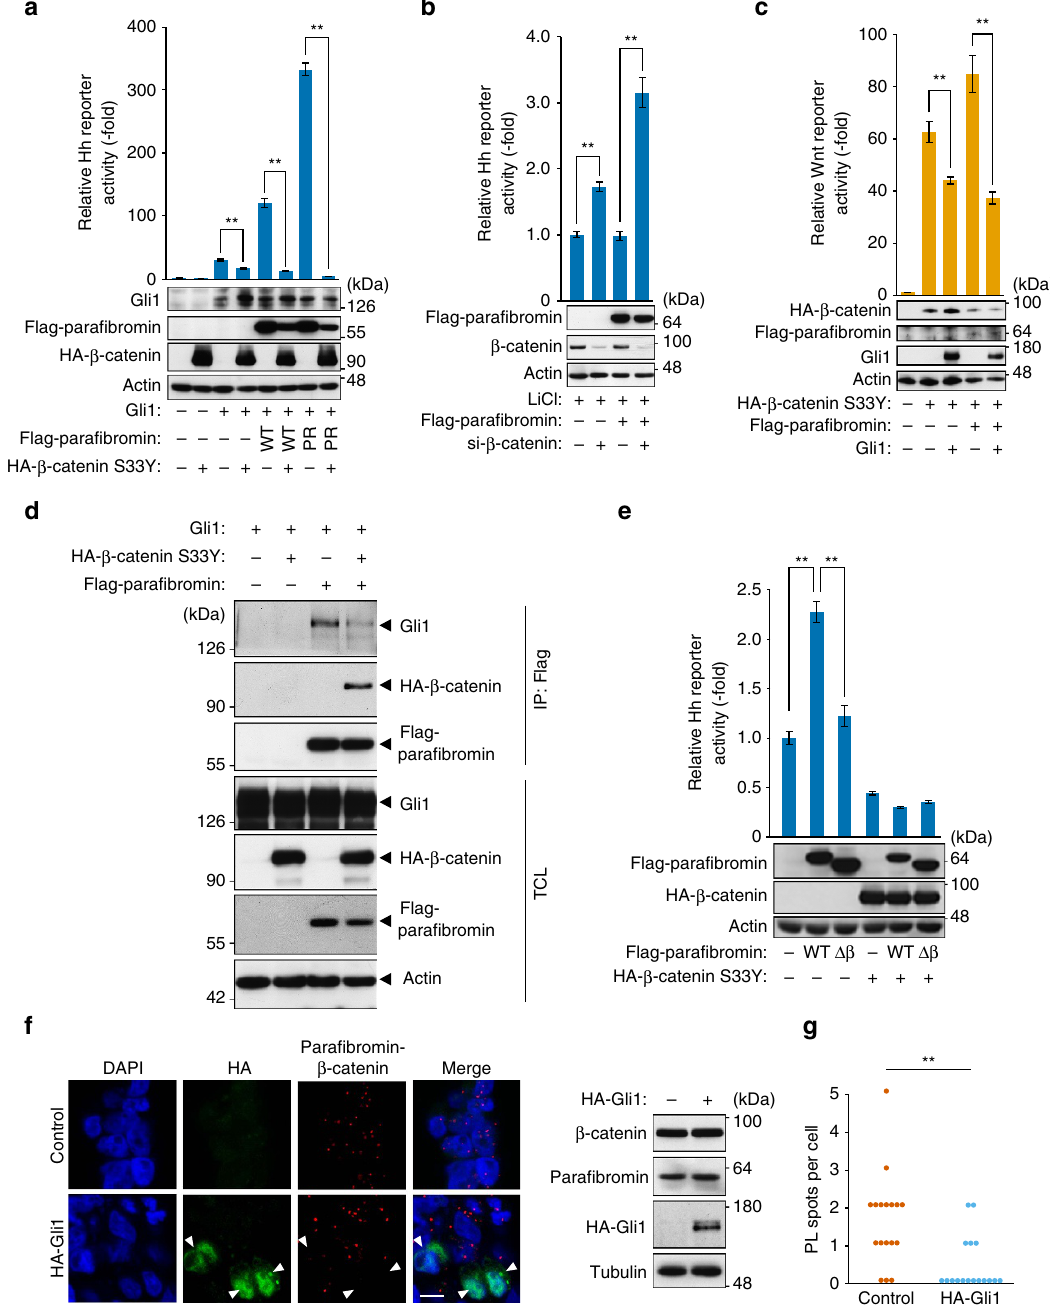
Figure 3 | Parafibromin activates Wnt and Hedgehog signals in a mutually exclusive manner. ( a , b ) b -catenin competitively inhibits parafibromin- dependent Hh signalling. Hh-responsive luciferase reporter assays were performed in HEK293T cells. Total cell lysates (TCLs) were subjected to immunoblotting ( n ¼ 3, mean ± s.d. ** P o 0.01; ANOVA with Bonferroni’s post hoc test). For b , transfected cells were treated with 25mM LiCl for 24h. ( c ) Gli1 suppresses parafibromin-dependent Wnt signalling. Wnt-responsive luciferase reporter assays were performed in HEK293T cells ( n ¼ 3, mean ± s.d. ** P o 0.01; ANOVA with Bonferroni’s post hoc test). ( d ) b -catenin competitively inhibits parafibromin/Gli1 interaction. HEK293T cells were transfected with the indicated vectors. TCLs were sequentially immunoprecipitated (IP) and immunoblotted. ( e ) A parafibromin mutant lacking b -catenin- binding site ( Db ) failed to potentiate Hh signal. Hh-responsive luciferase reporter assays were performed in HEK293T cells transfected with the Gli1 expression vector. Total cell lysates (TCLs) were subjected to immunoblotting ( n ¼ 3, mean ± s.d. ** P o 0.01; ANOVA with Bonferroni’s post hoc test). ( f ) Proximity ligation assay (PLA) in HEK293T cells. Transfected cells were treated with 25mM LiCl. Red spots indicate the parafibromin/ b -catenin interaction. Nuclei and Gli1-expressing cells were stained in blue (DAPI) and green, respectively. Scale bar, 10 m m. Protein expression levels in control and Gli1-expressing cells were indicated by immunoblotting. ( g ) Data for quantitative analysis of the PL spots; n ¼ 17. ** P o 0.01; Wilcoxon rank sum